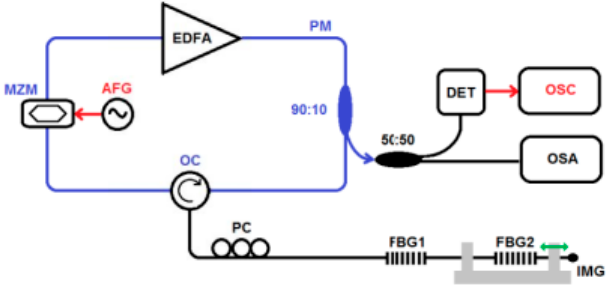
Figure 13 . Actively mode-locked (AML) erbium-doped fiber amplifier (EDFA)-based fiber ring laser for fiber Bragg gratings (FBGs) interrogation.